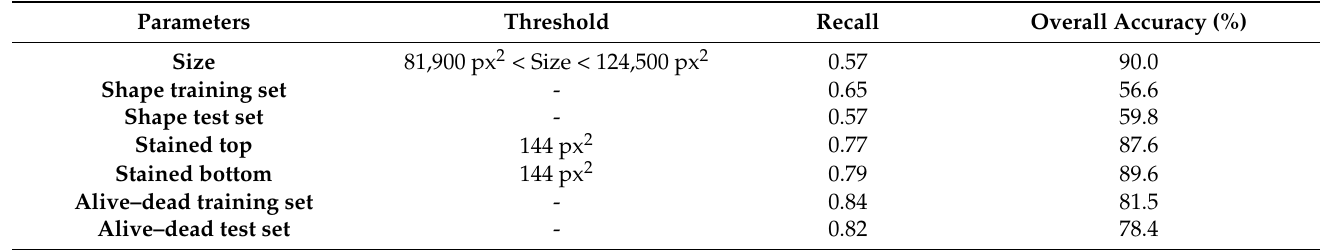
Table 5. Threshold values eventually used for discrimination, overall accuracy, and recall (see eq.) of the cocoon sorting prototype for the different parameters considered in this